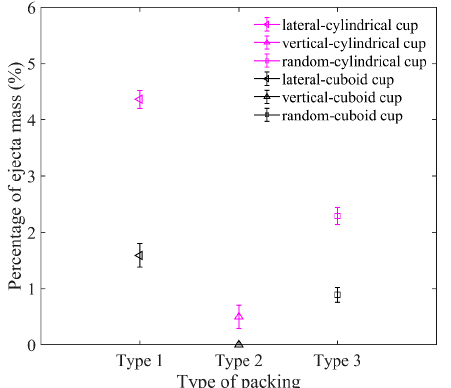
Figure 21. Comparison between ejecta masses for three packing types in cylindrical cup and cuboid cup. The length of particles in the cup is AR = 5.